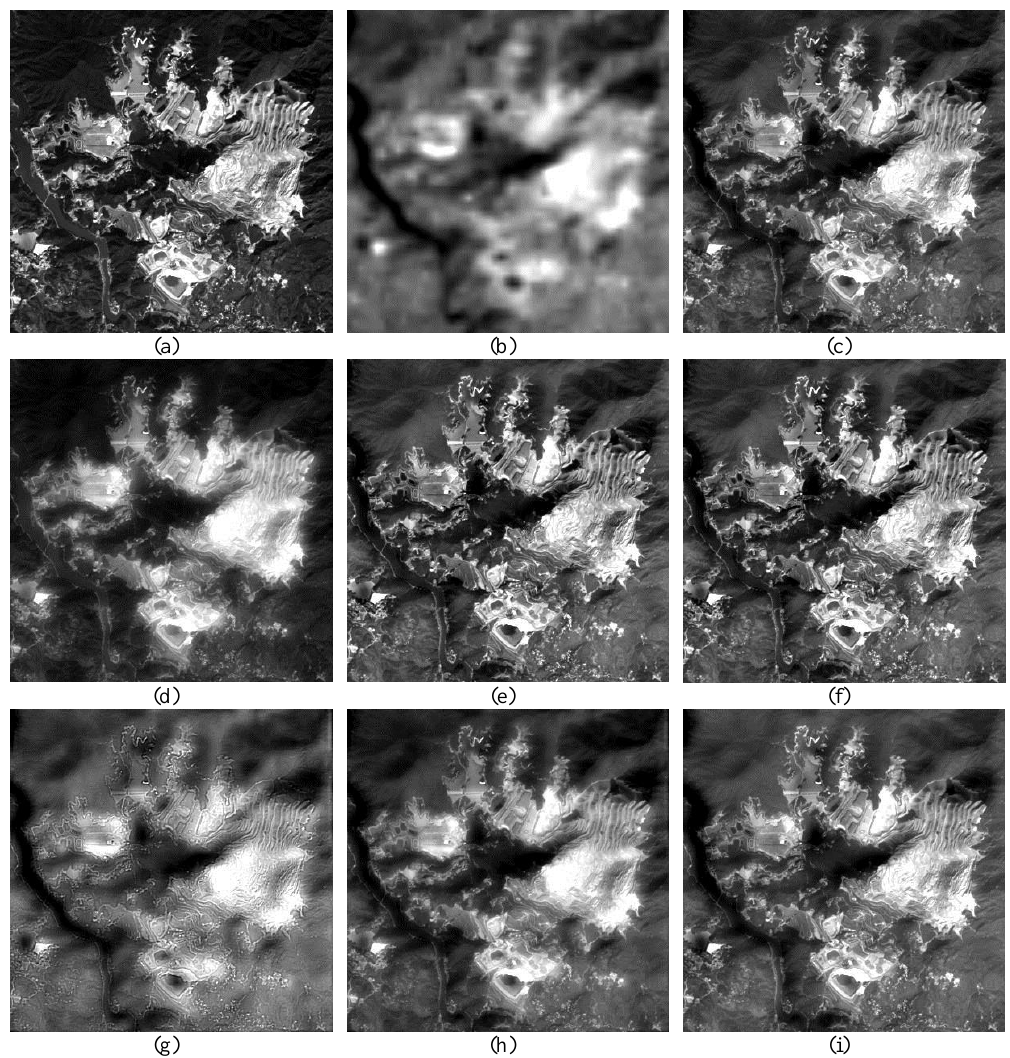
Figure 1. Original images and fused images from different methods in Zijin Mountain Mining Area: (a) original HR image, (b) original HS image, (c) proposed method, (d) original variational method, (e) PCA, (f) GS, (g) SFIM, (h) MTF-GLP, (i) CNMF.